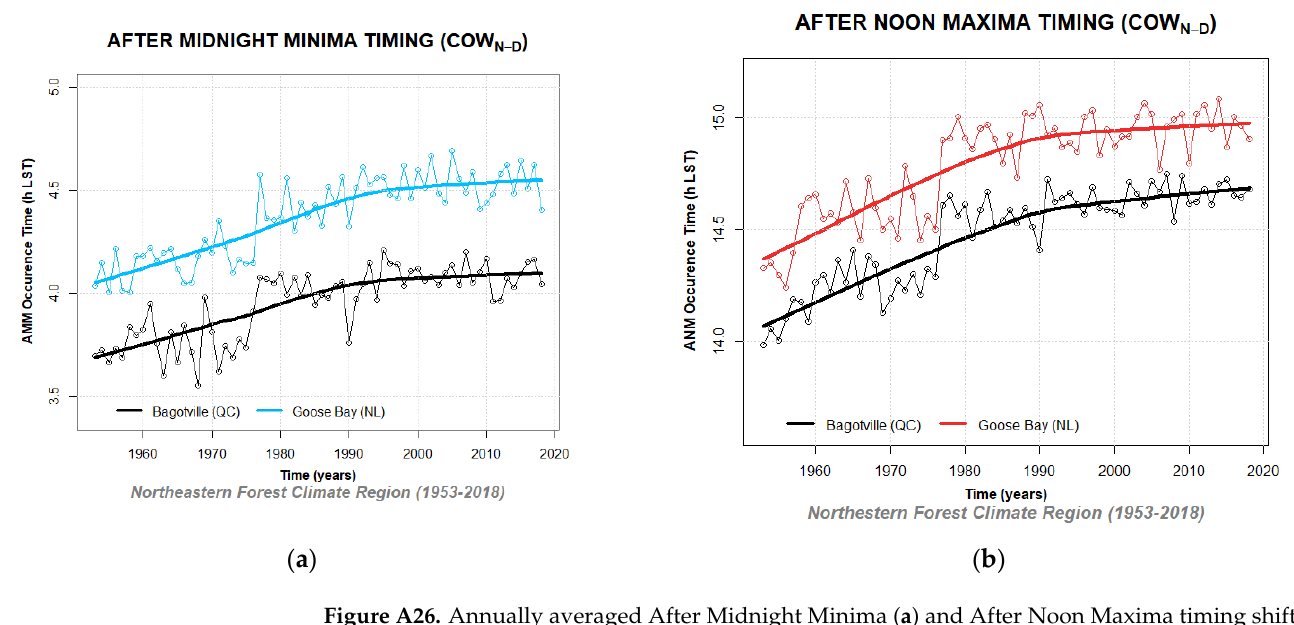
Figure A26. Annually averaged After Midnight Minima ( a ) and After Noon Maxima timing shifts ( b ) and LOESS fit curves for Bagotville (QC) and Goose (NL) temperature time series, Northeastern Forest climate region.